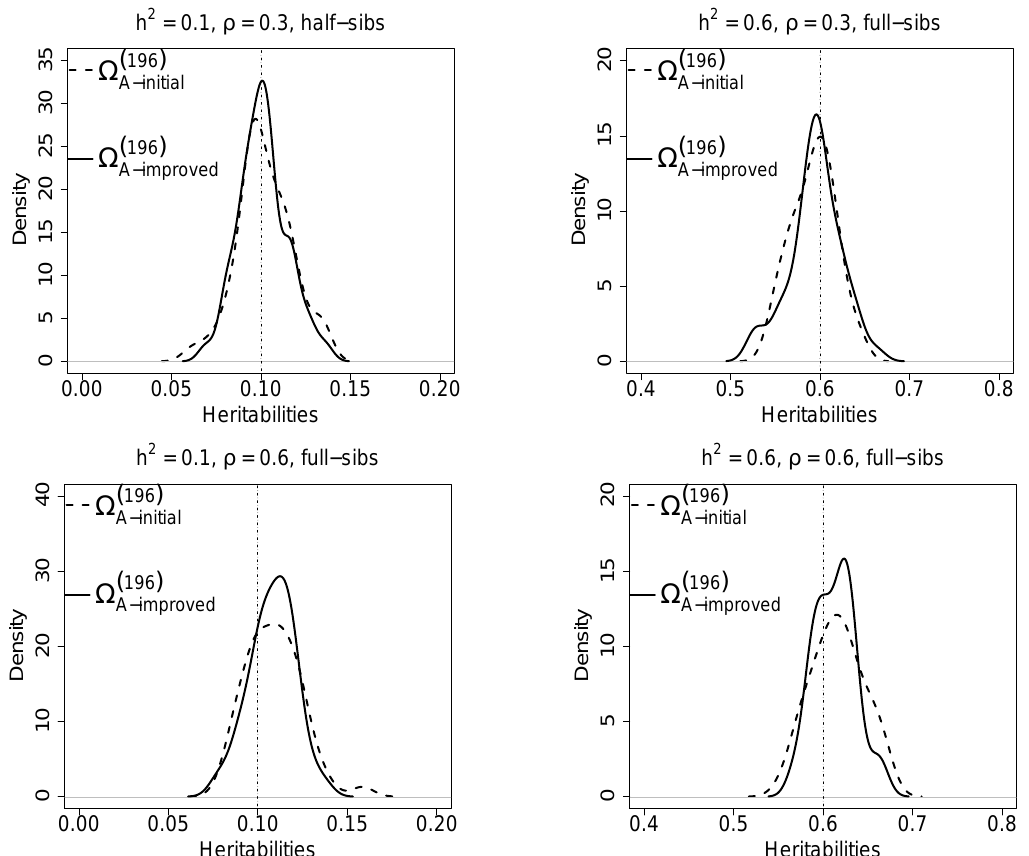
Figure 3. Kernel densities for estimated heritabilities. The vertical line represents the true heritability. Both initial and improved designs for different heritabilities and spatial correlations are presented ( 196 ) based on Ω . Each condition had λ = 50 replicates each iterated p = 5000 A